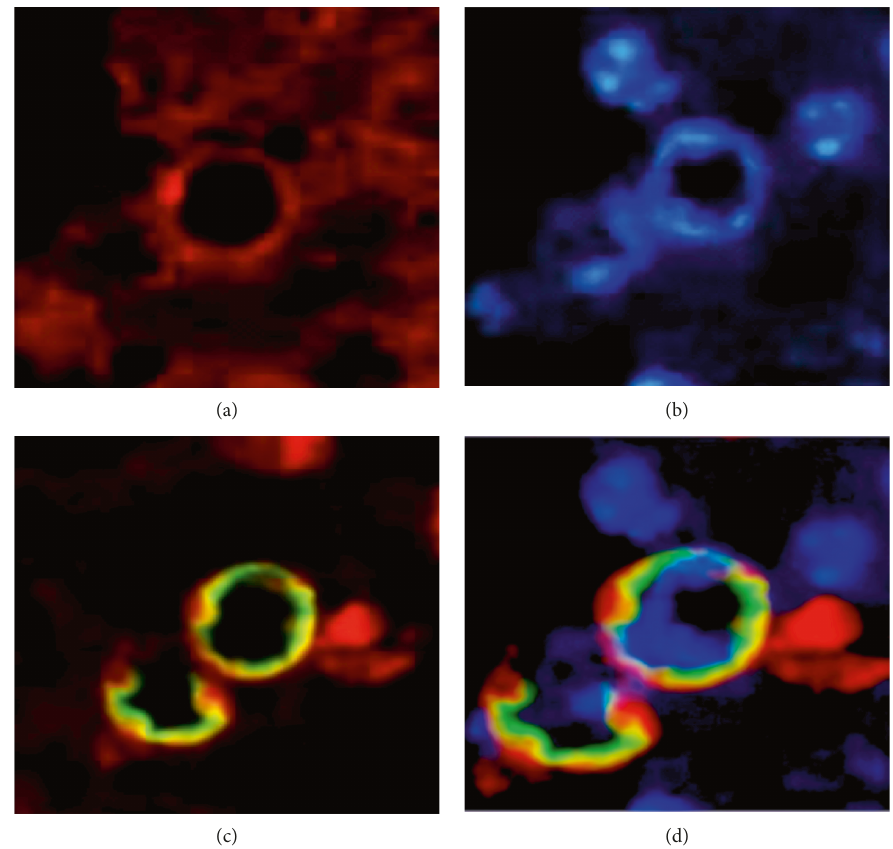
Figure 8: Ro60 expressed in apoptotic cells. (a) Ro60 is stained as red immuno fl uorescence. (b) Nuclei counterstained with DAPI as blue fl uorescence. (c) Double fl uorescence Ro ribonucleoprotein (red) in apoptotic cells (green) tagged by TUNEL assay in double fl uorescence test. (d) The results of a triple fl uorescence show Ro in red outside of apoptotic nuclei in green, and some of the remaining nuclei are stained in blue by